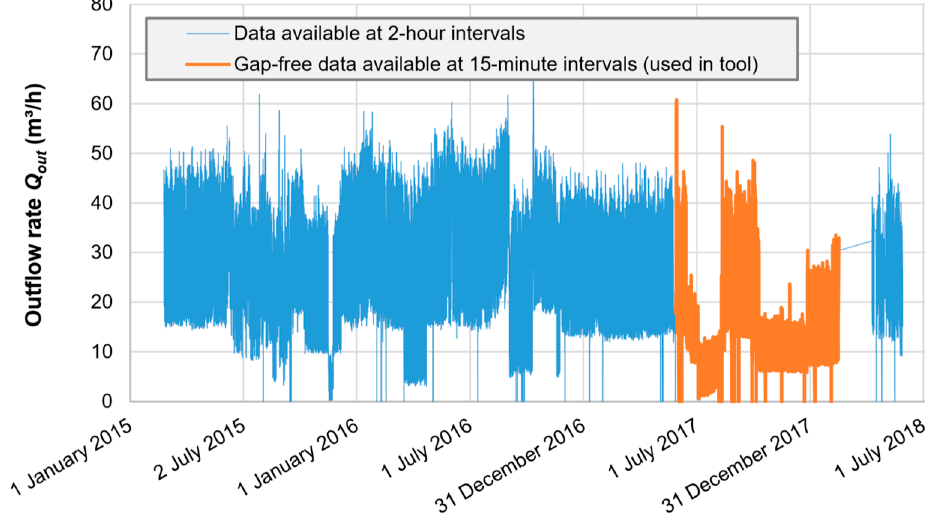
Figure 9. Outflow data series available for BPT Rützengrün, with the data used in the Excel tool highlighted in orange.